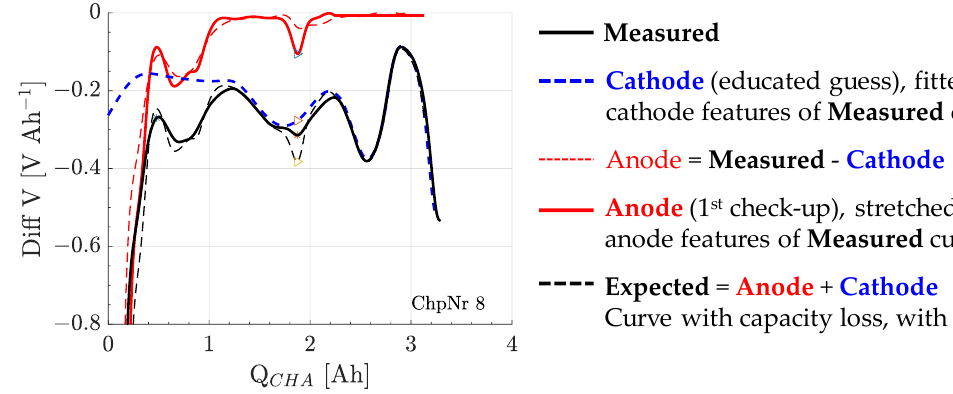
Figure A2. Schematic for the calculation of the DVA for the estimation of HLD.